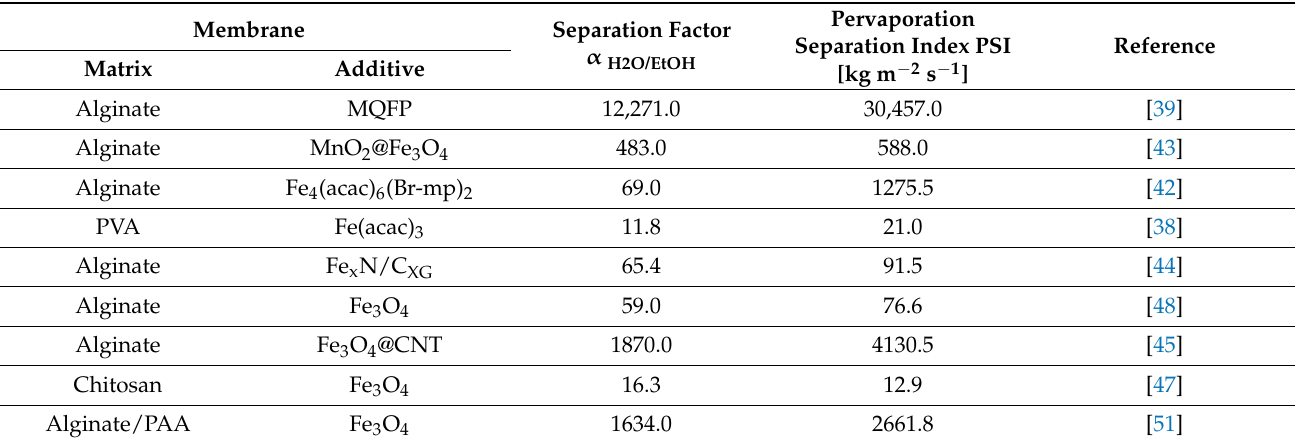
Table 3. Comparison of various magnetic membranes efficiency in pervaporative water/ethanol separation